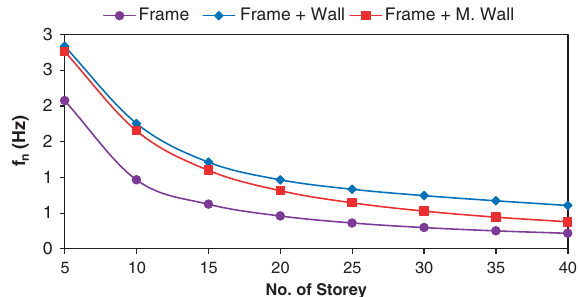
Fig. 9. Natural frequency, f n , for masonry walls inclusion